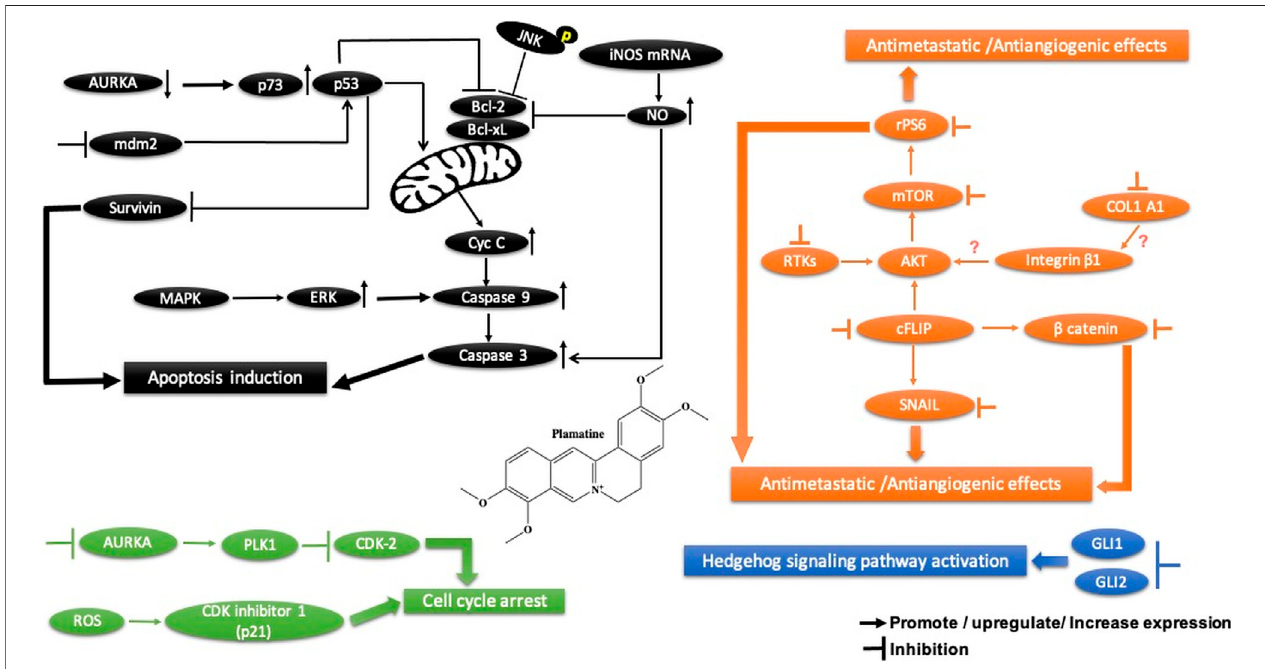
FIGURE 4 | Main mechanism of palmatine against cancer.